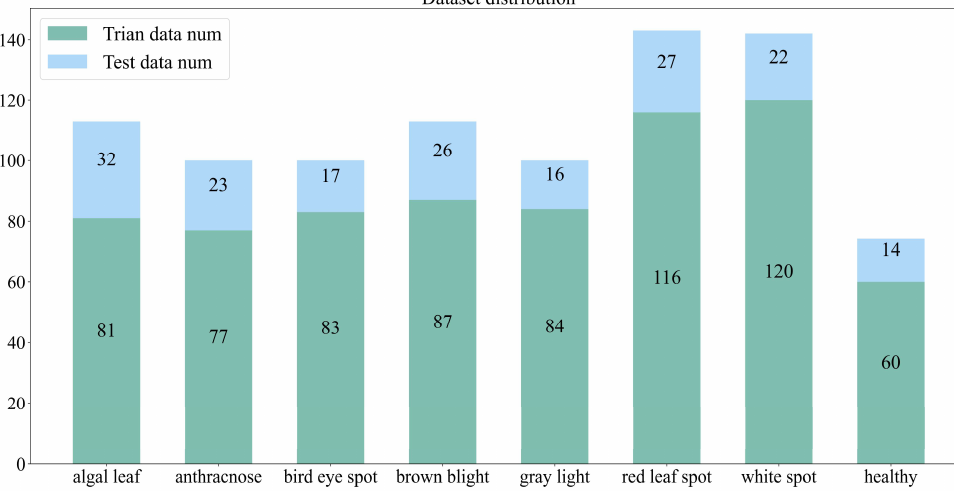
Figure 5. Distribution of the tea disease dataset.